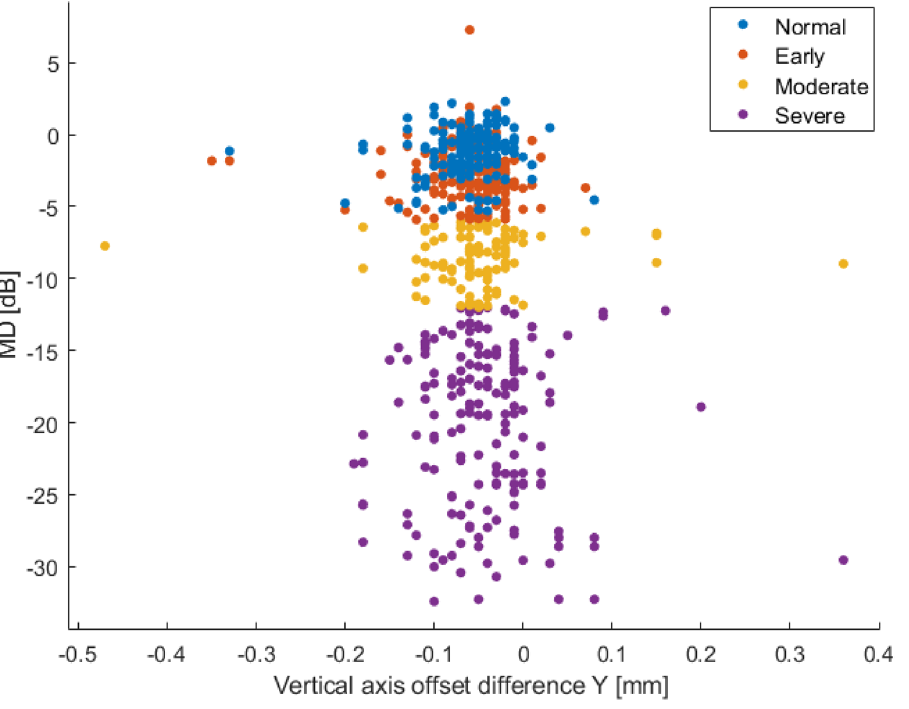
Figure 8. Classes distribution of vertical offset difference regard to vertical axis and the mean deviation (MD).